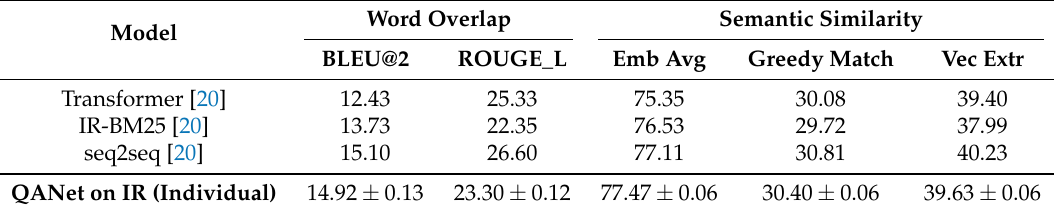
Table 3. Main task: performance of the individual